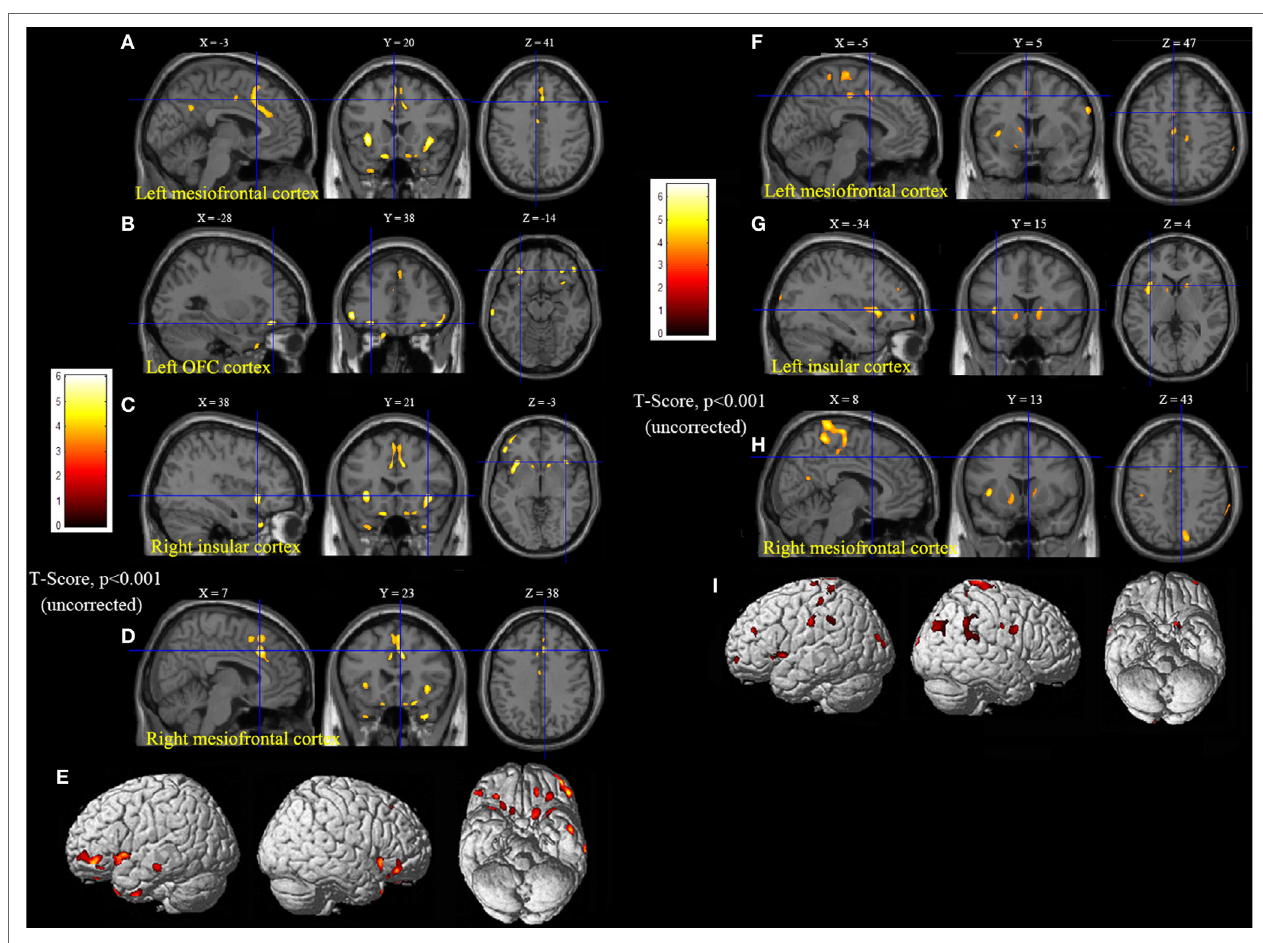
FigUre 3 | Statistical parametric mapping analysis results from the HMS1 group (a–e) and the HMS2 group (F–i) compared with the control group. The anterosuperior insular lobe, the head of the caudate nucleus, and the mesiofrontal cortex were found to be hypometabolic in each hypermotor seizures (HMS) subgroup. Compared with the HMS2 group, patients in the HMS1 group showed more extensive hypometabolic regions, including the left cingulate cortex (a) , left orbitofrontal cortex (b,e) , right insular cortex (c) , and left temporal pole (e) . Note that PET images in patients with right-sided epileptogenic zones were transposed horizontally, and all HMS were supposed to originate from left hemisphere. The color scale means T scores for the slice view. The surface view of significant results was presented in the 3D map (e,i) and color bar was not